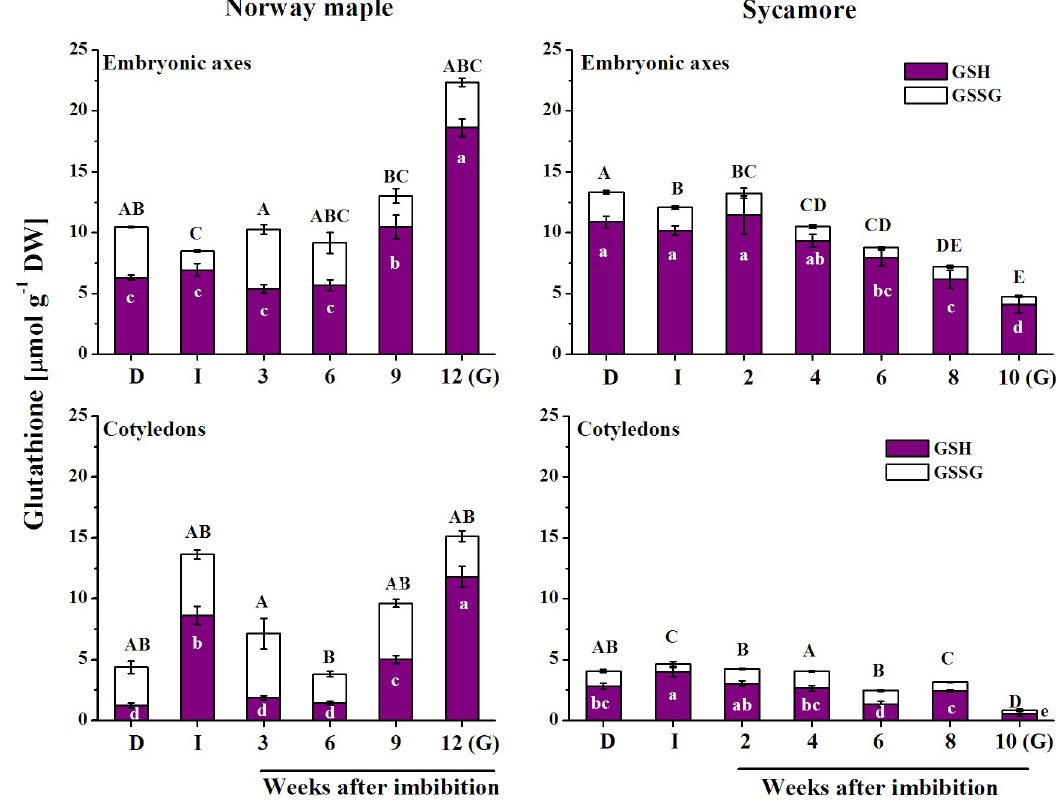
Fig 6. Changes in the levels of the reduced (GSH) and oxidized (GSSG) forms of glutathione reported in the embryonic axes and cotyledons of dry and germinating Norway maple and sycamore seeds. (D) Dry seeds; (I) Imbibed seeds; (G) Germinated seeds. Data are the means of three independent replicates ± std. Statistically significant differences are indicated with different letters (one-way ANOVA, followed by Tukey’s test at p < 0.05). The capital letters refer to GSSG.